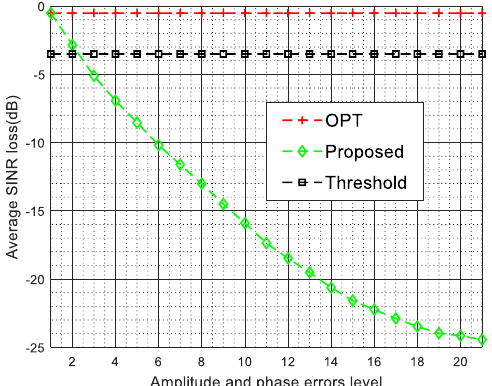
Figure 4. Average SINR loss versus the amplitude and phase errors level.